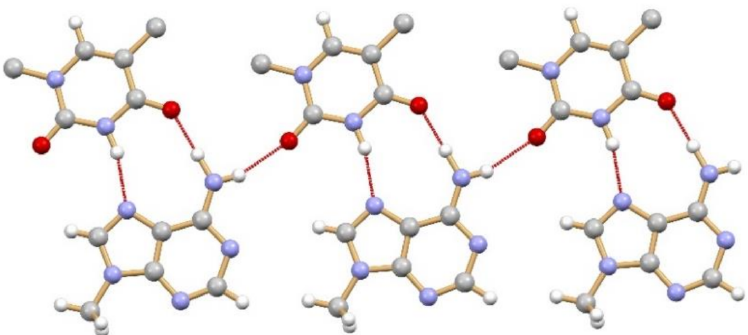
Figure 22. Hydrogen bonding pattern in the 1:1 co-crystal of 1-methyl adenine and 1-methyl thymine, first reported in 1963 by Hoogsteen (CSD refcode